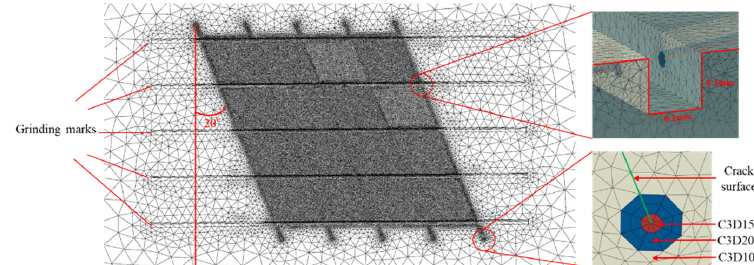
Figure 7. Schematic diagram of crack model with grinding marks.